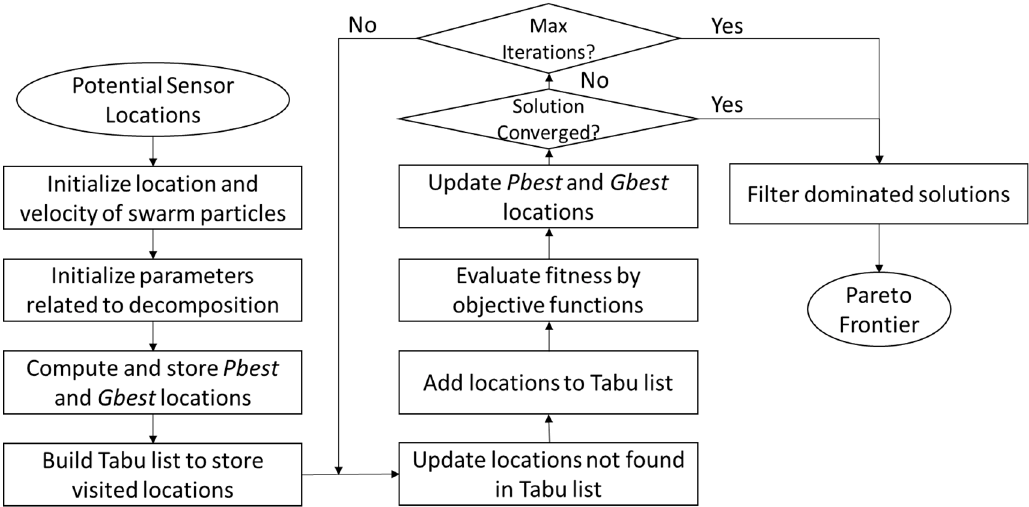
Figure 2. Flowchart of the discrete decomposition-based multiobjective particle swarm optimization (DMOPSO) algorithm.